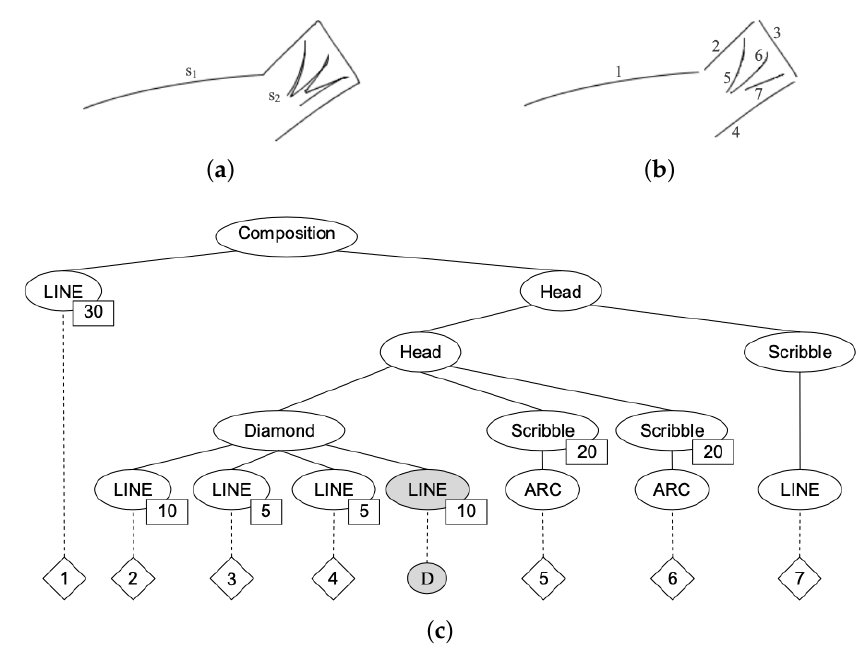
Figure 9. A Composition symbol with a missing stroke ( a ), its segmentation ( b ), and the parse tree constructed by the parser with error recovery ( c